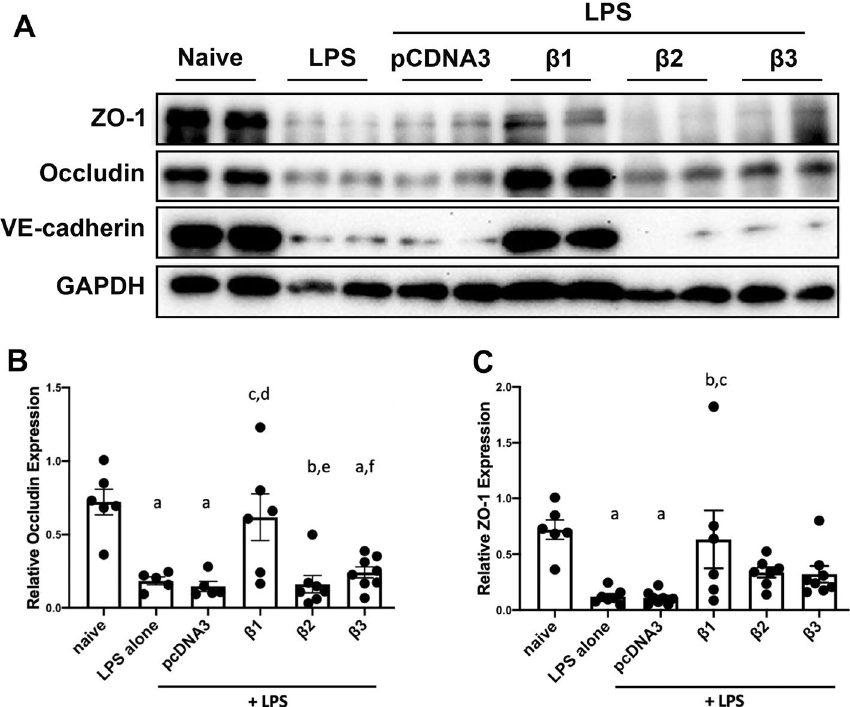
Figure 7. Gene transfer of the Na + ,K + -ATPase β1 subunit has the unique ability, compared to the β2 and β3 subunits, to restore ZO-1, occludin, and VE-cadherin expression in previously LPS injured lungs. Lung injury was established in C57B6 mice (n = 6–8) by aspiration of LPS (5 mg/kg) and 1 day later plasmids (100 μg each) expressing either no insert (pcDNA3), or the β1, β2, or β3 subunits of the Na + ,K + -ATPase (β1, β2, or β3) were delivered in 50 μl to the lungs by aspiration followed immediately by electroporation. Two days later, lungs were perfused with PBS and lysates were prepared for analysis by Western Blot ( A ). Levels of expression were normalized to GAPDH as a loading control and the relative expression of Occludin ( B ) and ZO-1 ( C ) are shown as mean ± SEM. All experiments were carried out three times and representative experiments are shown. One-way ANOVA with post-hoc Tukey’s multiple comparisons was used for statistical analysis; For Occludin ( B ) a, p < 0.01 compared to naïve; b, p < 0.001 compared to naïve; c, p < 0.05 compared to LPS alone; d, p < 0.01 compared to LPS + pcDNA3; e, p < 0.01 compared to LPS + β1; f, p < 0.05 compared to LPS + β1. For ZO-1 ( C ) a, p < 0.01 compared to naïve; b, p < 0.05 compared to LPS alone; c, p < 0.05 compared to LPS + pcDNA3. Full gels are in Fig.